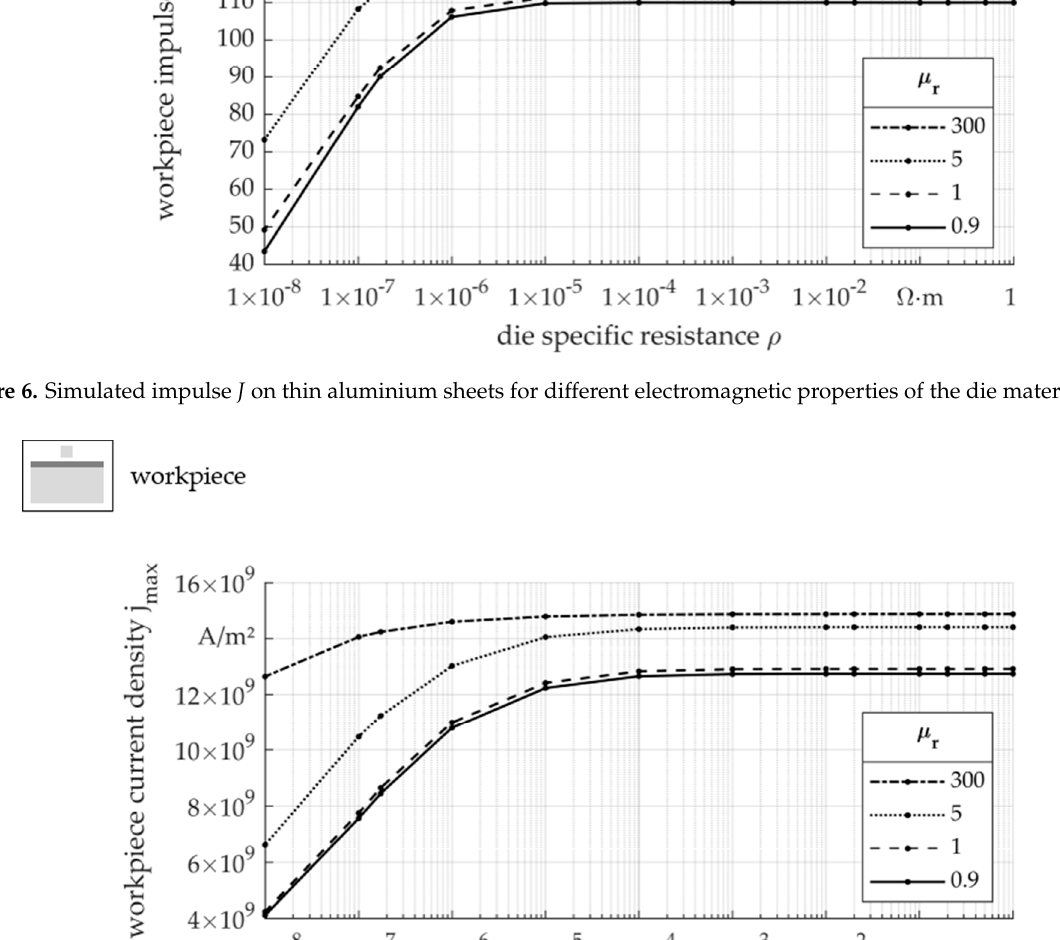
Figure 6. Simulated impulse J on thin aluminium sheets for different electromagnetic properties of the die material.